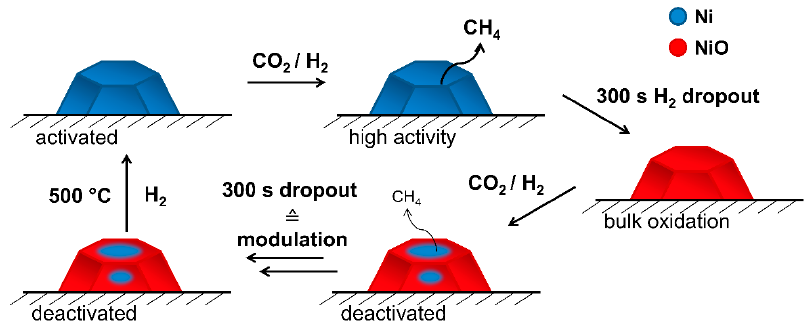
Figure 10. Scheme of the structure of the supported Ni particles exposed to H 2 dropout modulations at a duration of 300 s.